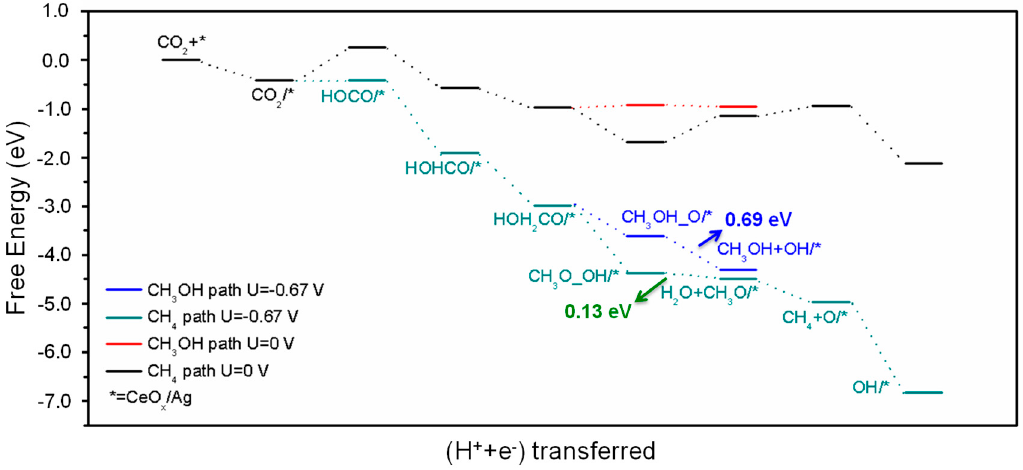
Figure 8. Free energy diagram for CO 2 reduction on CeO x /Ag(111) along HOCO* pathway at − 0.67 V (RHE).